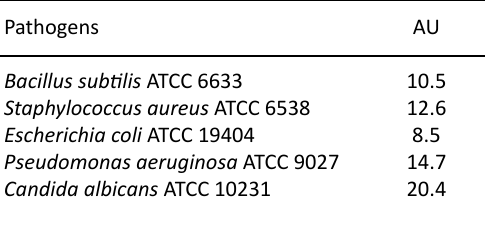
Table 1. Antimicrobial activity of the EPS produced by Halomonas sp. NASH expressed as absolute unit